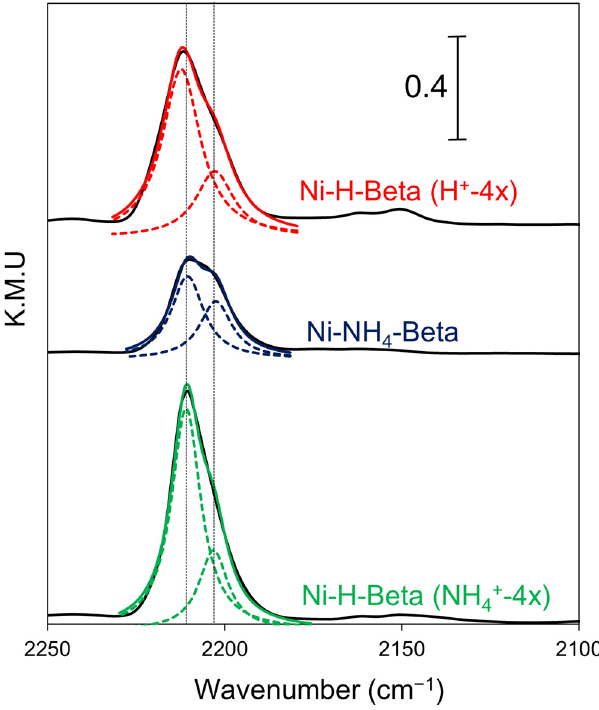
Figure 6. CO DRIFT spectra of catalysts after in situ pretreatment at 350 °C. Spectra measured after CO adsorption at 20 °C. Dashed curves are spectra deconvolutions.